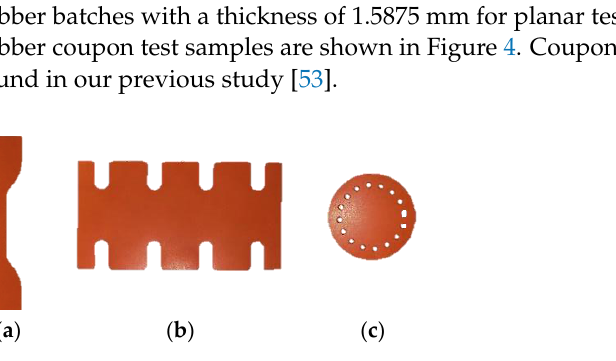
Figure 3. Component tests sample used to validate material parameters: O-ring multi-contact test.